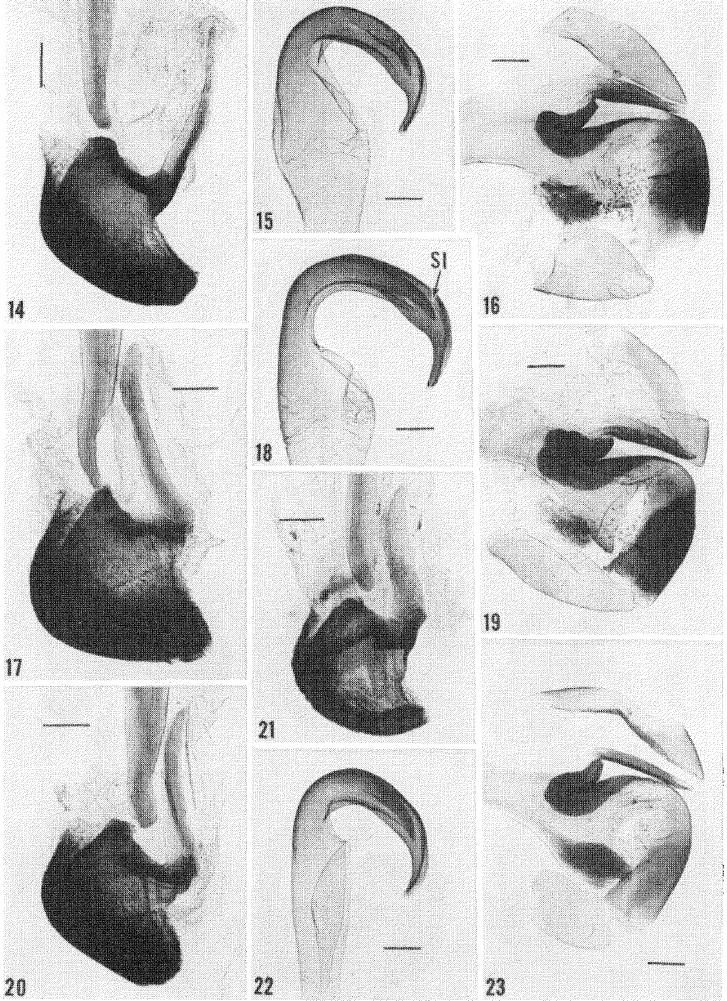
Figs. 14-23. Cockroach male genitalia. EpilamlSra fallax. 14-16. (51 ANSP). Sapucay, Paraguay (det. Roth). 17-18. (66 USNM). Santa Cata- rina, Brazil. (det. Albuquerque). (SI Subapical Incision). 19-20. (73 USNM). Santa Catarina, Brazil. (det. Albuquerque’). 21-23. (103 USNM). Rio Lujer, Buenos Aires, Argentina (det. Albuquerque). (in Fig. 21 the prepuce is collapsed). (scale 0.2